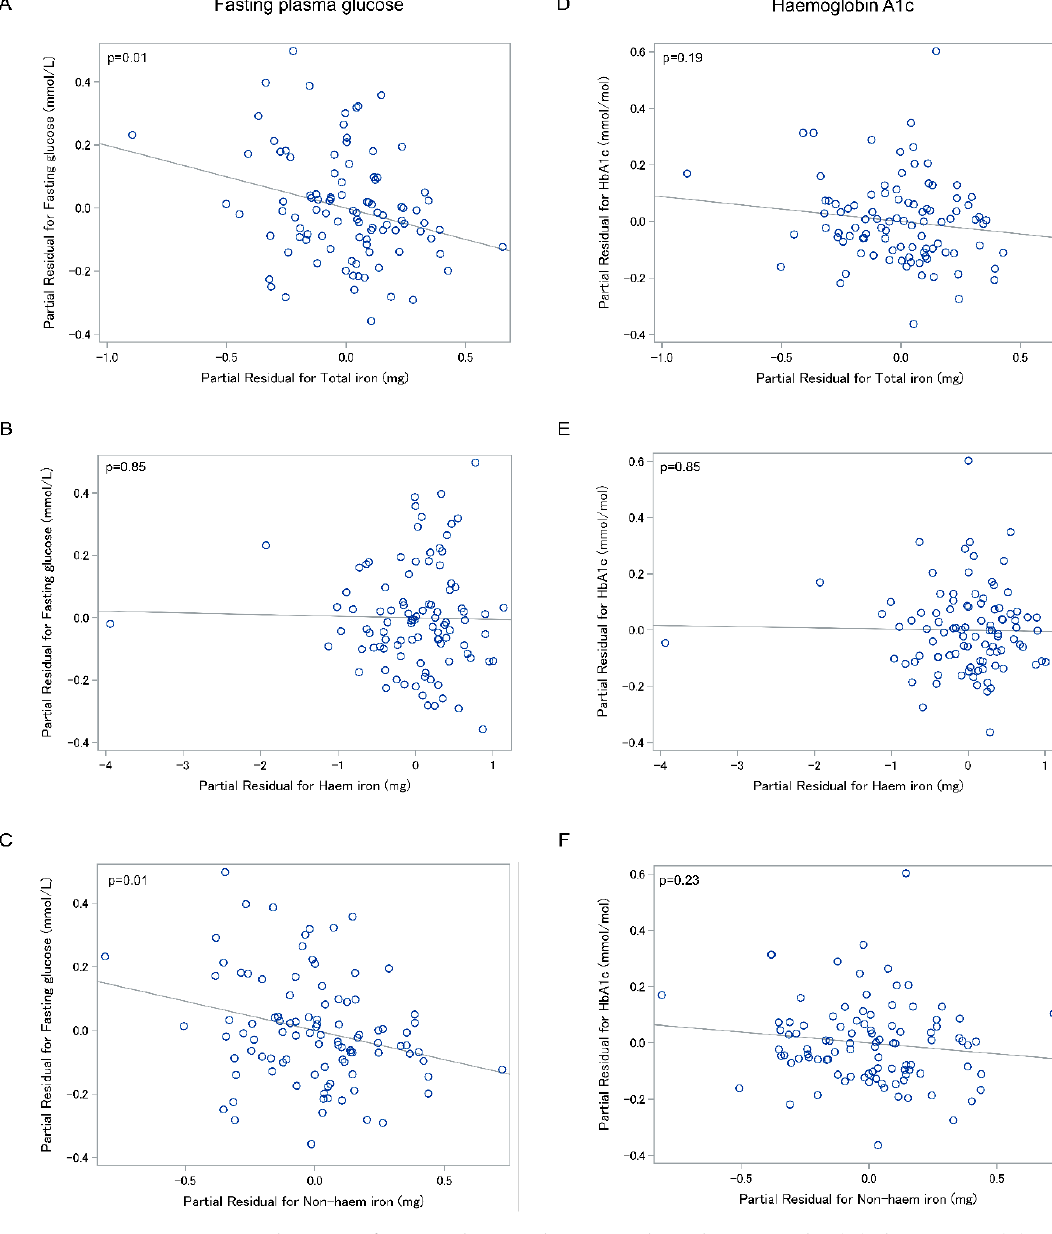
Figure 1. Associations between fasting plasma glucose and total iron intake ( A ), haem iron ( B ), and non-haem iron ( C ); haemoglobin A1c and total iron intake ( D ), haem iron ( E ), and non-haem iron ( F ) in the entire cohort. Footnote: All partial residual plots were adjusted for energy (kcal), age, sex, body mass index category, tobacco smoking, alcohol consumption, triglycerides, and use of anti-diabetic medications.